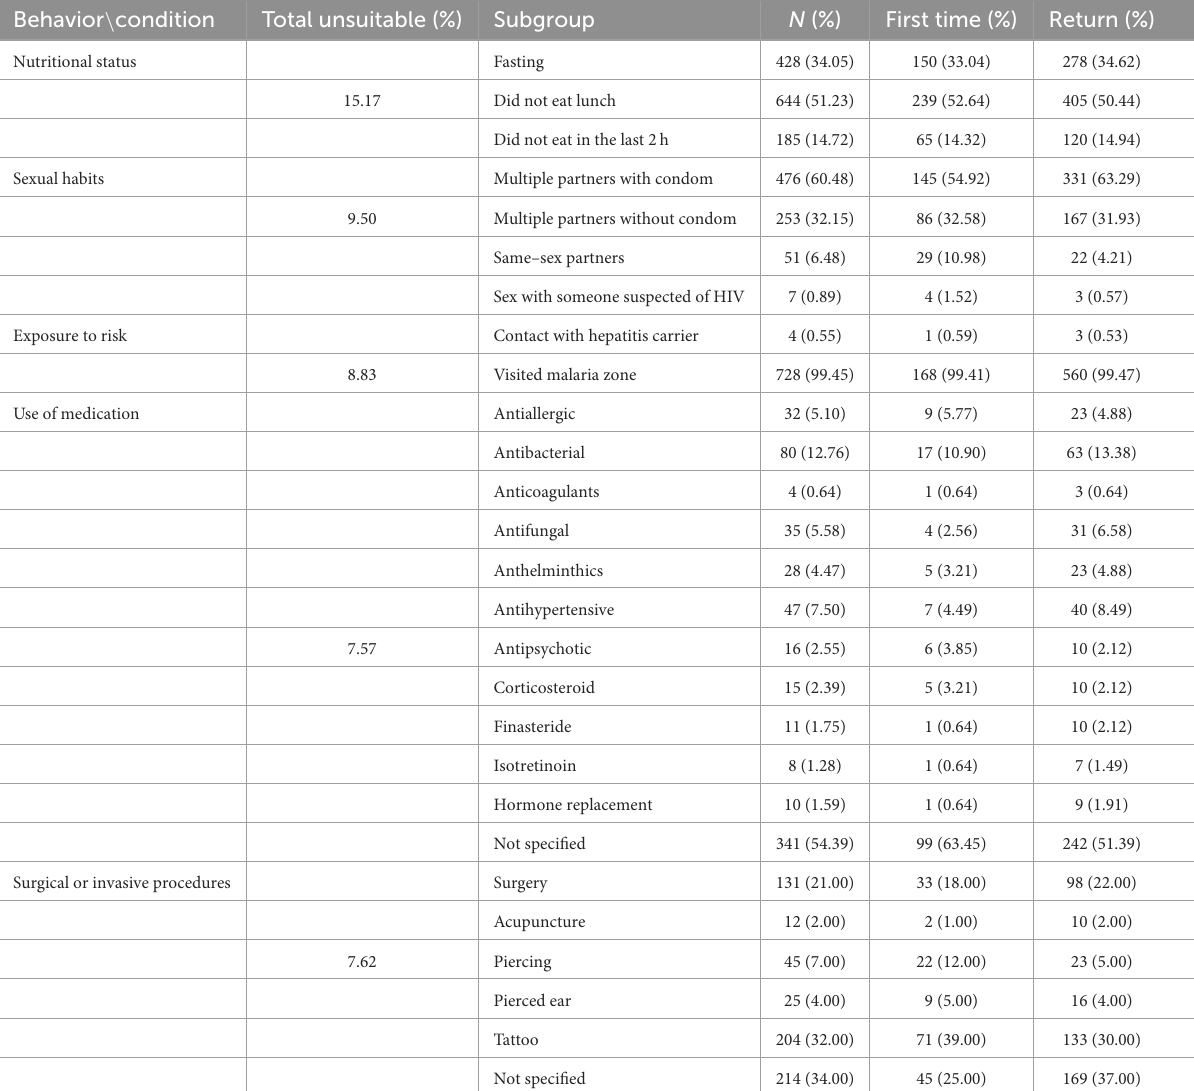
TABLE 3 Reasons for being unsuitable during clinical screening stratified according to non-disease-related variables in the 2017–2019 triennium. Behavior \